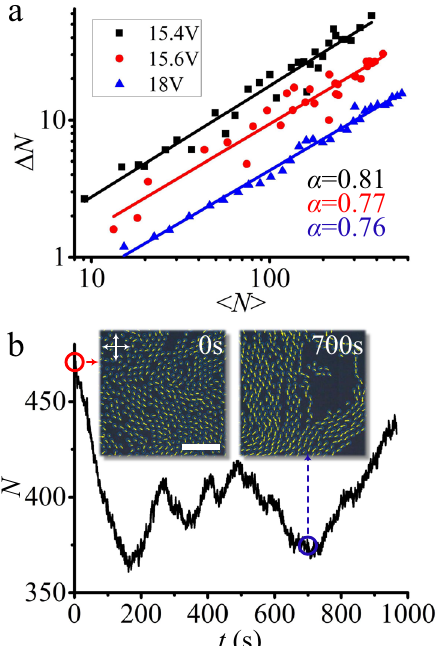
Fig. 8 Anomalous density fl uctuations in collectively moving directrons. a The log-log plot of the standard deviation Δ N versus the mean directron number < N > for three different voltages: U = 15.4 V (black squares), U = 15.6 V (red circles) and U = 18.0 V (blue triangles). The frequency is fi xed at f = 100 Hz. Solid lines are the linear fi ts of the experimental data. b Total number of directrons, N , in the fi eld of view (306 μ m * 306 μ m) as a function of time. The insets show the polarizing micrographs of the directrons at t = 0 s (red circle) and t = 700 s (blue circle), respectively, with their velocities represented as yellow arrows. U = 15.6 V, f = 100 Hz. Scale bar 100 μ m. The crossed polarizers are indicated as white